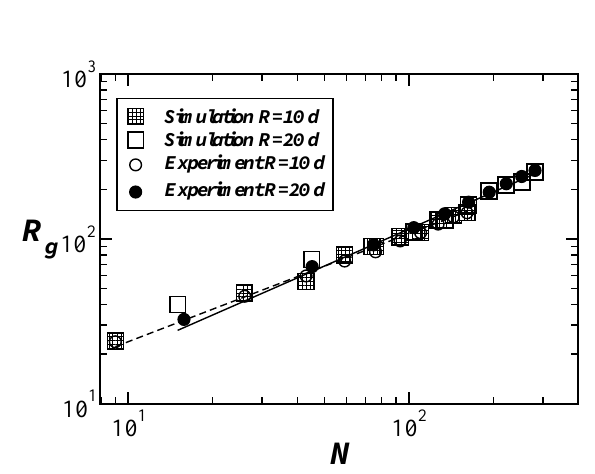
Figure 3. Radius R g ( N ) of a circle around the center versus the number N of particles inside the circle. The lines are least- squares fits to the data, giving the exponents d f = 1 . 55 ± 0 . 04 for R = 10 d (open circles) and d f = 1 . 34 ± 0 . 03 for R = 20 d (full circles).